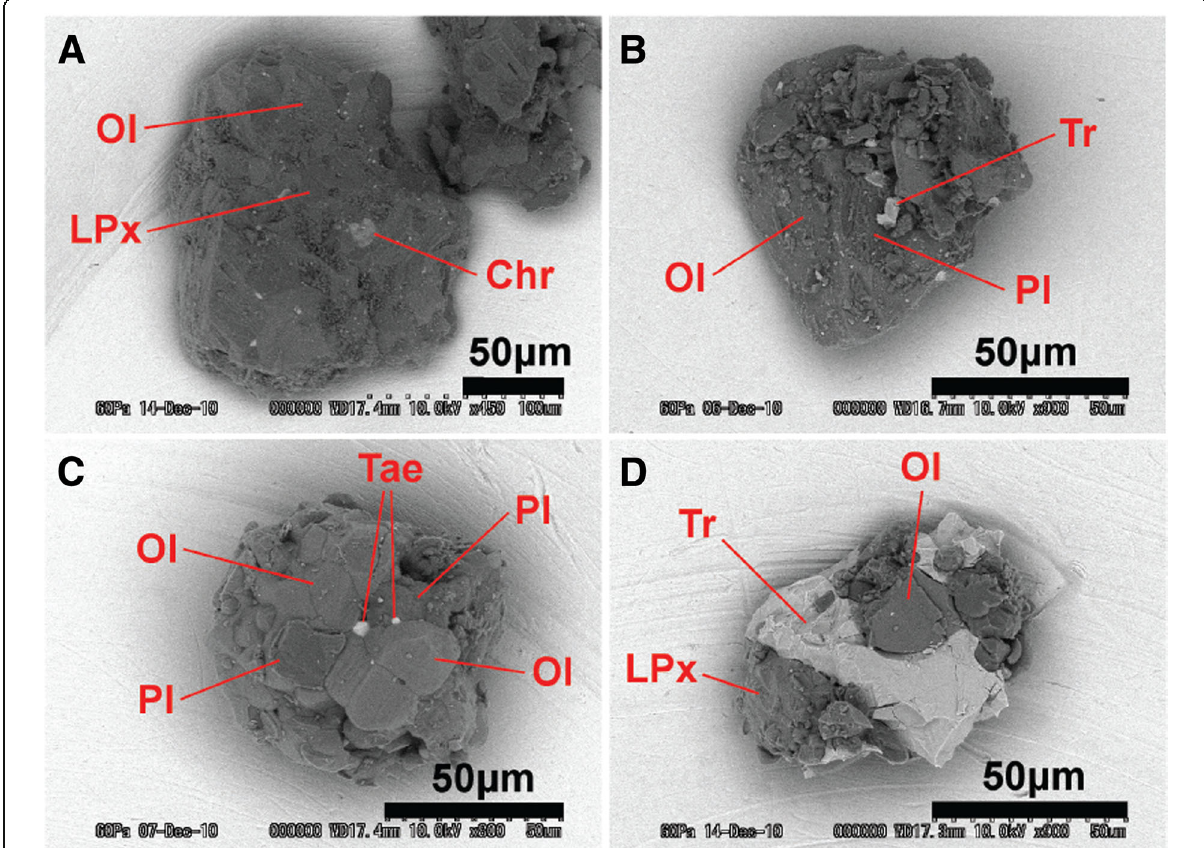
Fig. 11 Backscattered electron (BSE) images of asteroid Itokawa regolith grains RA-QD02-0030 ( a ), RA-QD02-0024 ( b ), RA-QD02-0013 ( c ), and RA- QD02-0027 ( d ) from Nakamura et al. (2011). Ol, olivine; LPx, low-Ca pyroxene; Chr, chromite; Pl, plagioclase; Tr, troilite; Tae,